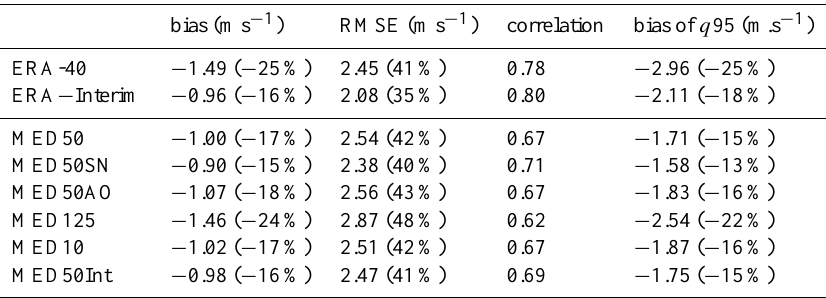
Table 4. Mean values over 2000–2001 and over the Eastern Basin for the bias, the RMSE, the temporal correlation and the 95th percentile bias of the daily wind speed compared with QuikSCAT for ERA-40, ERA-Interim and each ALADIN simulation. Percentages indicate the ratio relative to QuikSCAT mean value (for bias and RMSE) and q 95 value (for q 95